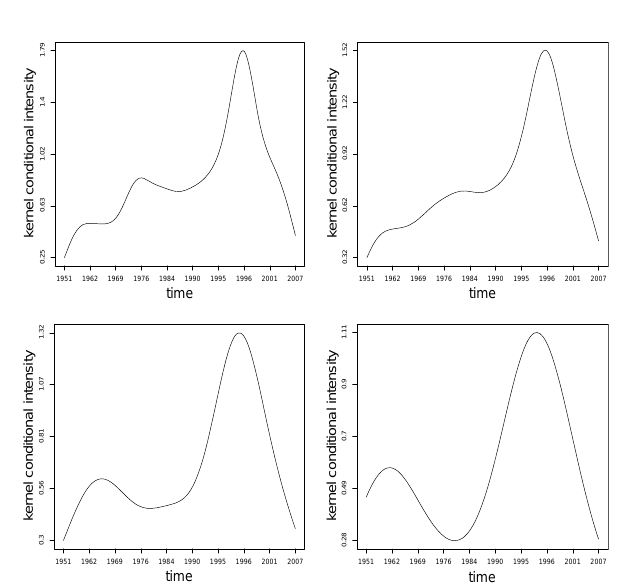
Fig. 4. Temporal conditional kernel intensity for all magnitude events (on the top left), with M ≥ 5 (on the top right), with M ≥ 5 . 5 (on the bottom left), with M ≥ 6 (on the bottom right).